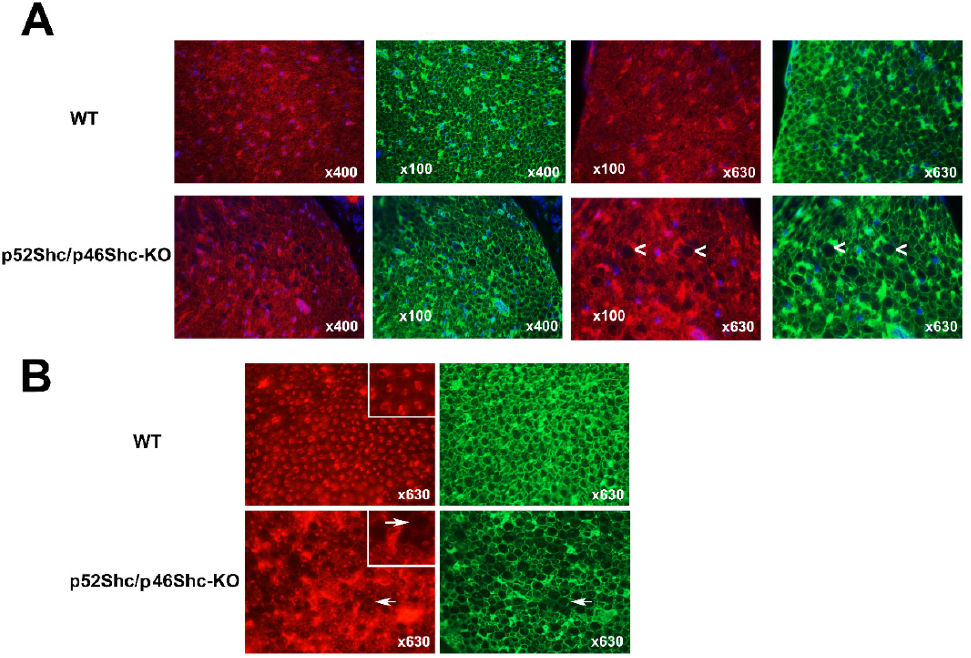
Figure 5. Analysis of sciatic nerve cross-sections of p52Shc/p46Shc-KO rats and WT littermates. ( A ) Cross-sections of sciatic nerve were stained with anti-NCAM antibody (red staining) and WGA-fluorescein (green staining). DAPI (blue staining) was used to visualize nuclei. White arrowheads indicate large myelin sheets that are missing axons in the cross-sections of p52Shc/p46Shc-KO rats. ( B ) Cross-sections of sciatic nerve were stained with anti-PMCA antibody (red staining) and WGA-fluorescein (green staining). White arrows indicate large myelin sheets that are missing axons in the cross sections of p52Shc/p46Shc-KO rats.